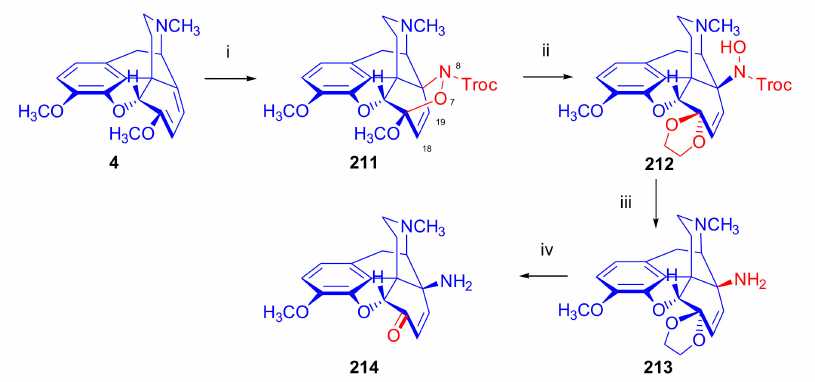
Figure 57. Synthesis of 14-aminocodeinone from thebaine. Reagents and conditions : (i): 2,2,2- trichloroethyl N -hydroxycarbamate, sodium periodate, EtOAc, 0.5 M sodium acetate (aq., pH 6), 0 ◦ C, 1 h, 82%; (ii): 0.26 M hydrogen chloride in ethylene glycol, room temperature, 2 h, 95%; (iii): (NH 4 ) 2 CO 3 , Zn powder, 70 ◦ C, 1 h, 87%; and (iv): 6M HCl, MeOH-H 2 O 2:1 ( v/v ), reflux, 30 min,